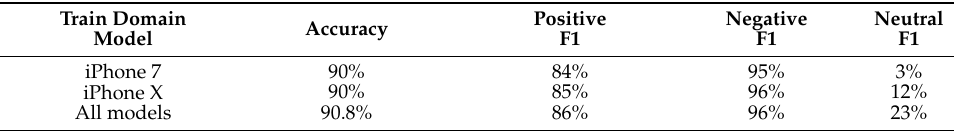
Table 6. Performance of LFSC-A via various train domain choices.